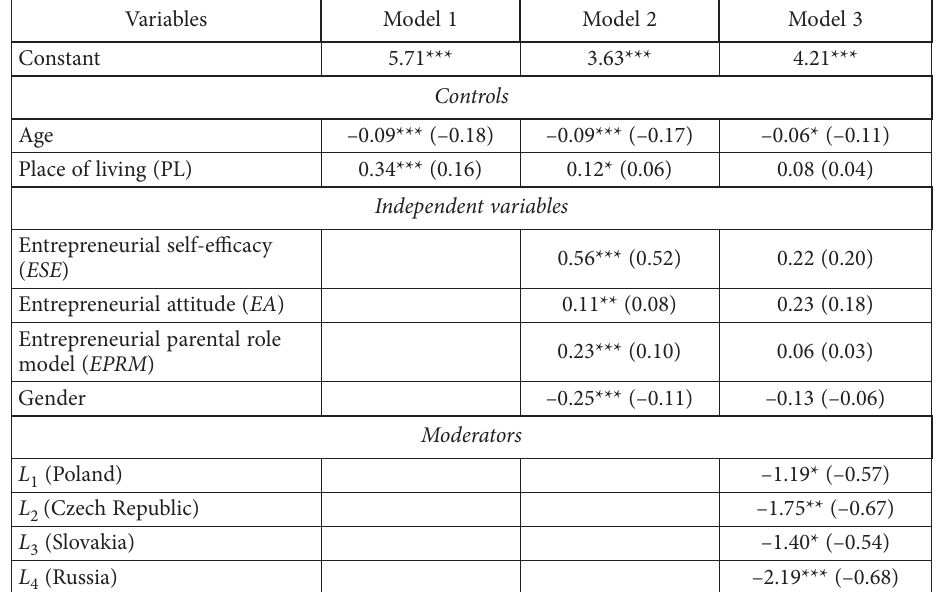
Table 4. Parameter estimates of hierarchical multiple OLS